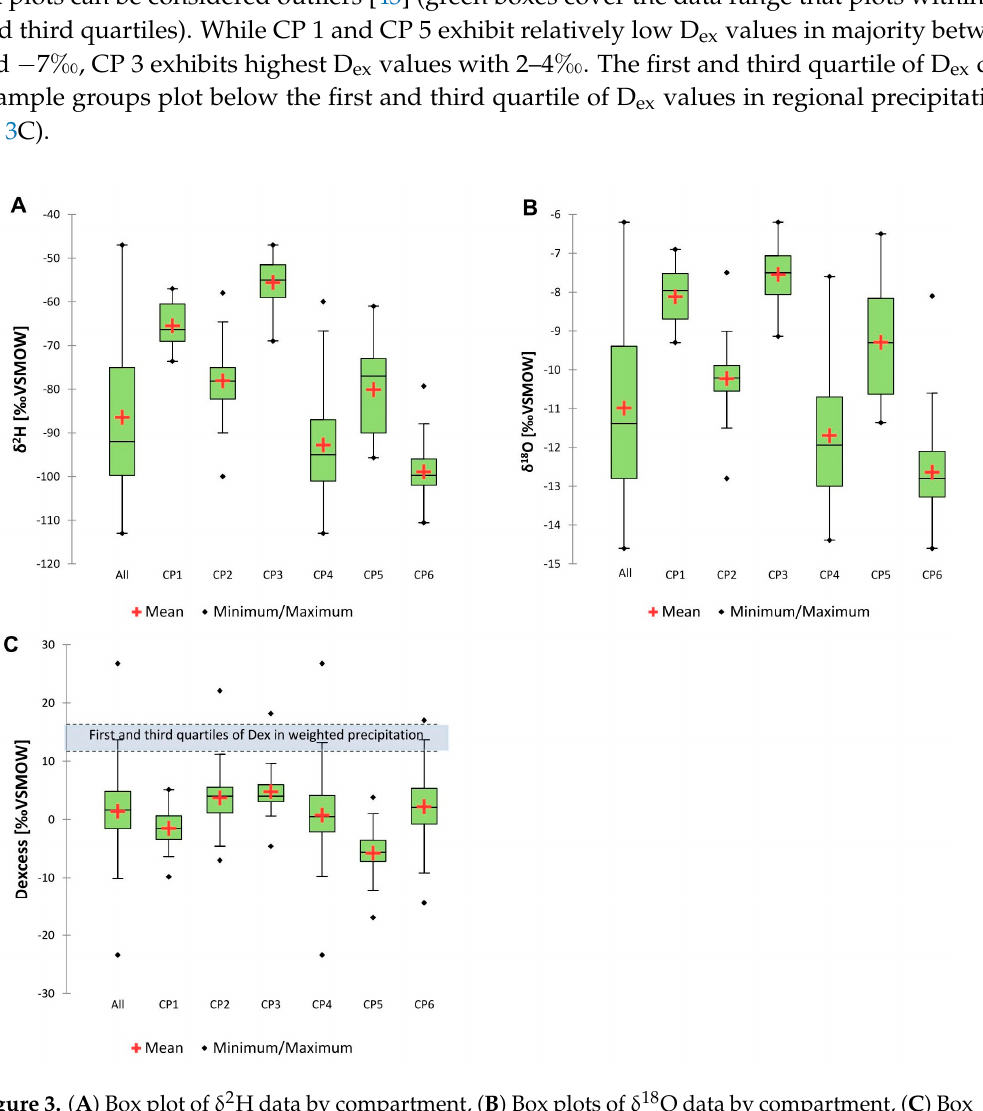
Figure 3. ( A ) Box plot of δ 2 H data by compartment, ( B ) Box plots of δ 18 O data by compartment, ( C ) Box plot of D ex values by compartment, lower values are an indication for a higher isotope fractionation by evaporation (higher evaporative loss) (no significant difference in D ex values of precipitations of north-western and east-north-eastern air masses).